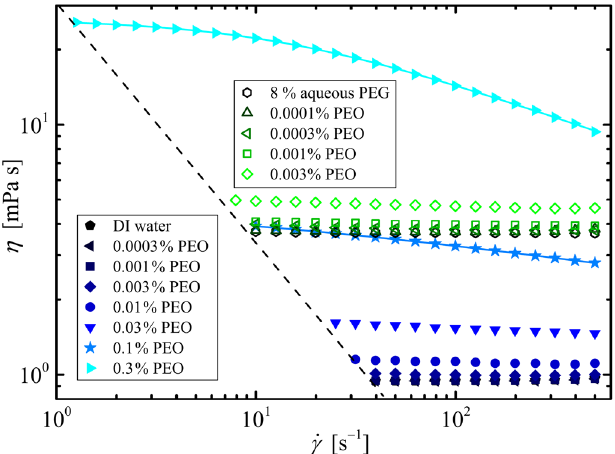
FIG. 2. Shear viscosity measurements with a stress-controlled rotational rheometer (Anton Paar MCR 502) for PEO solutions of various concentrations in two different solvents: water and 8 wt % aqueous PEG. Curve fitting for the shear-thinning fluids is done with the Carreau-Yasuda GNF model [Eq. (1)]. The diagonal dashed line represents 10 × the minimum sensitivity of the